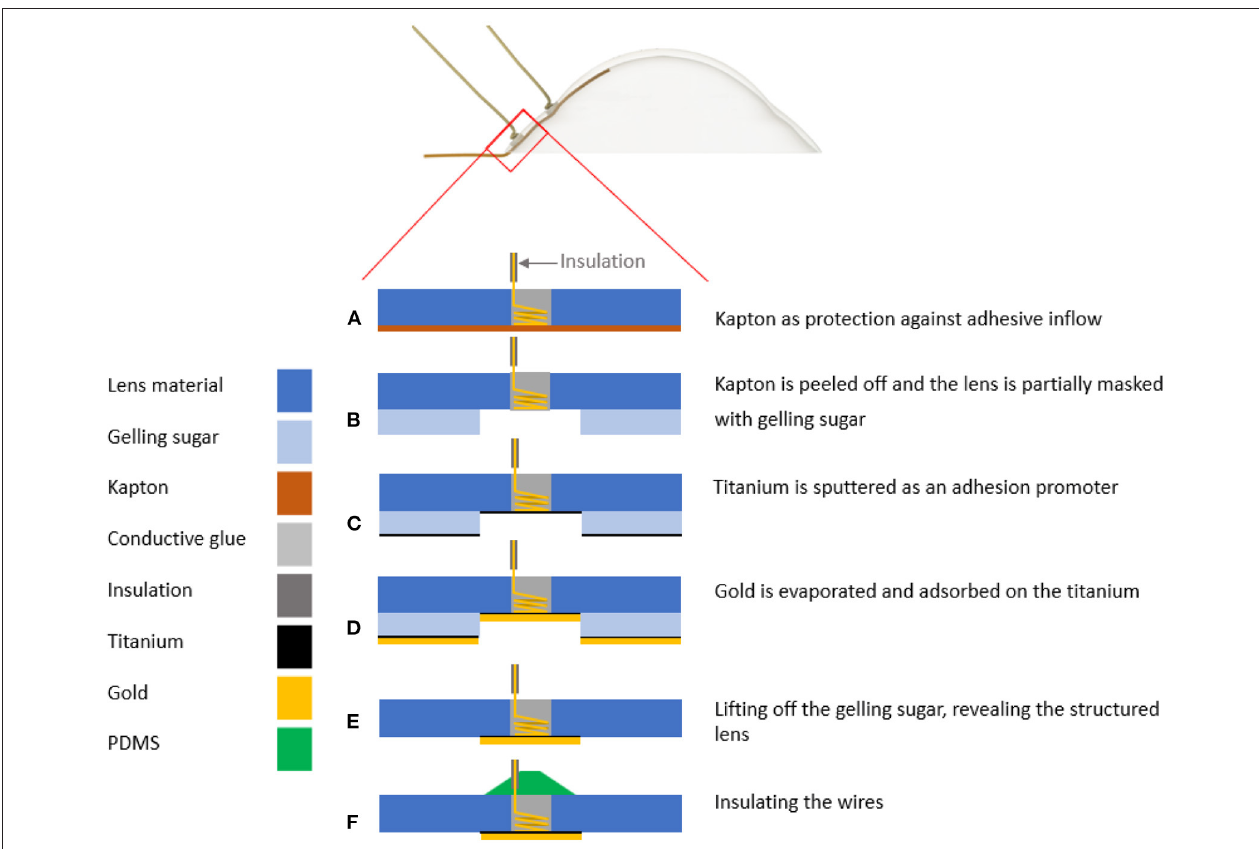
FIGURE 5 | Schematic representation of the steps of the lift-off procedure. (A) After the biocompatible, conductive adhesive has cured in the drill hole, the Kapton® can be peeled off. (B) Masking of the substrate on the concave side with gelling sugar is performed (C) , followed by sputtering of the titanium layer with a thickness of 20nm. (D) Immediately afterwards, the gold layer with a thickness of 150nm is deposited. (E) The lift-off step follows, in which the gelling sugar is dissolved with distilled water in an ultrasonic bath. (F) Finally, the contact points of the convex side of the lens are insulated with silicone polydimethylsiloxane